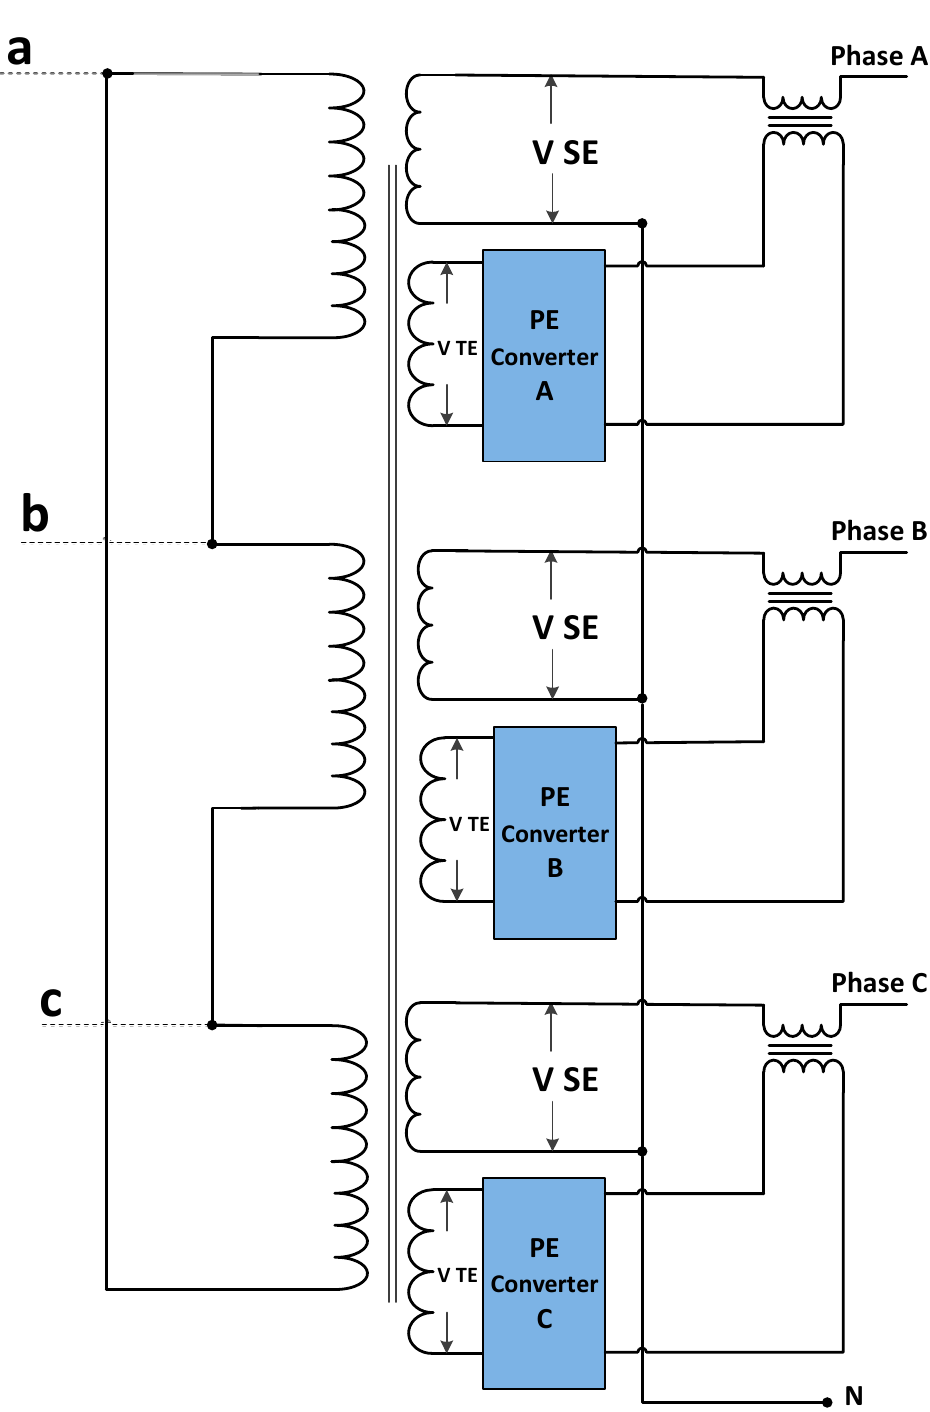
Figure 2. The proposed HT-based approach, which is a conventional transformer that is attached partially to an AC/AC converter with a DC link and series transformer.